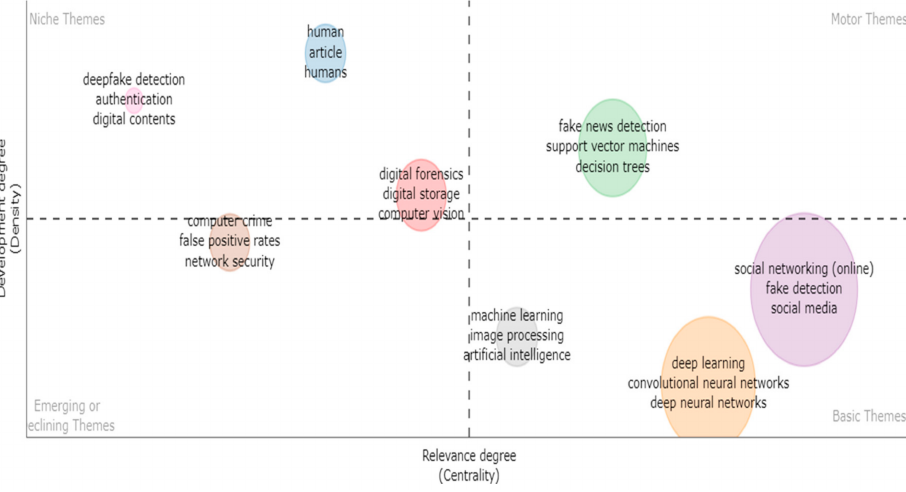
Figure 18. Thematic